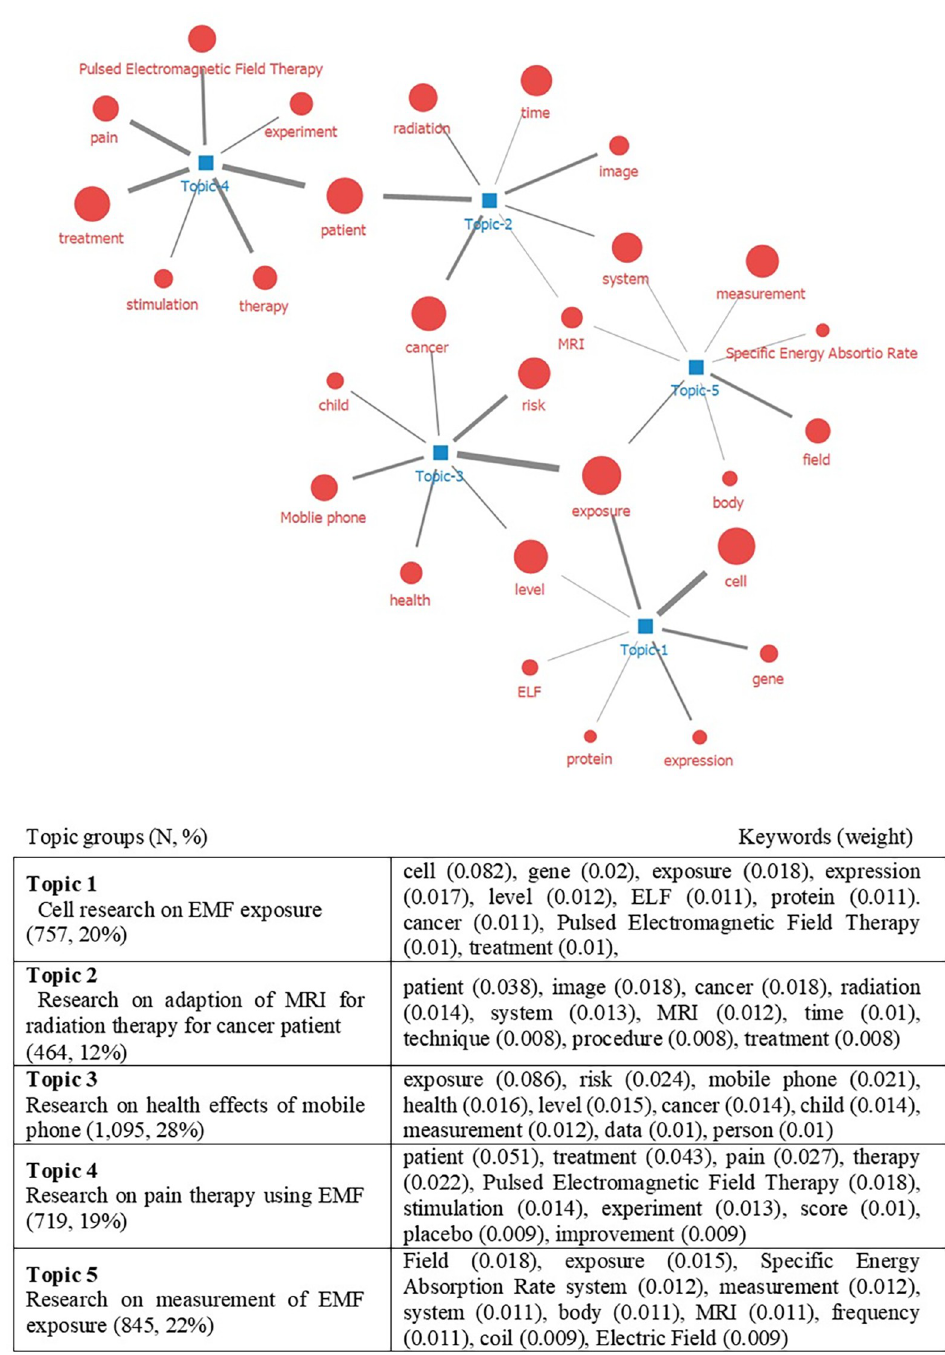
Fig 3. Topic modeling of electromagnetic field and health research. N indicates the number of main documents on each topic. The weight refers to the degree to which the keyword represents the topic.